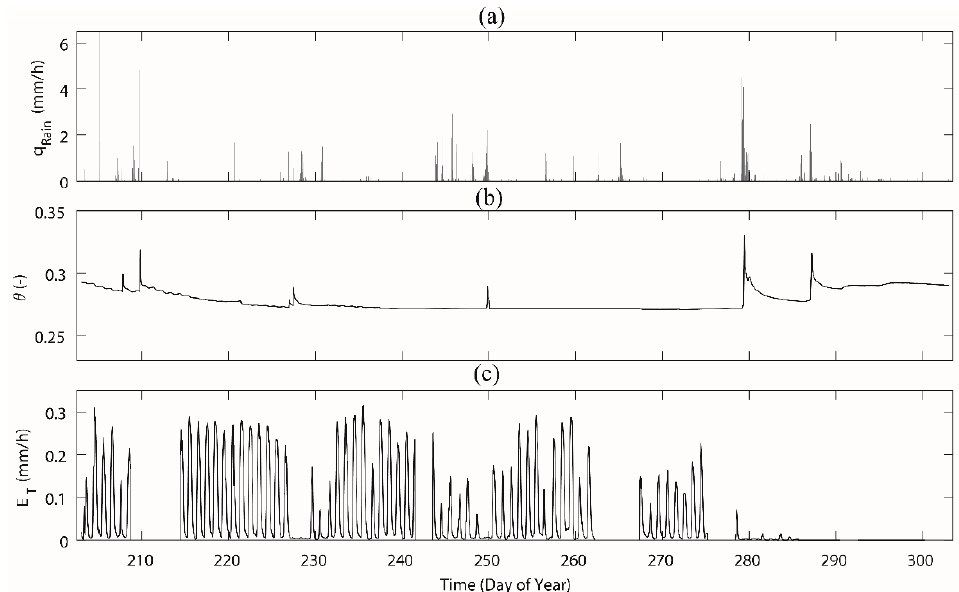
Figure 5. The measurements of ( a ) rainfall, ( b ) soil moisture, and ( c ) stand sap flow in the study area Rokytka (ROK) during the day of year 203–302. Abbreviations: q rain —rainfall, θ —averaged soil moisture based on measured soil moisture from a depth of 20 cm and 60 cm, E T —calculated transpiration based on measured sap flow from six beech trees. A data gap of transpiration from